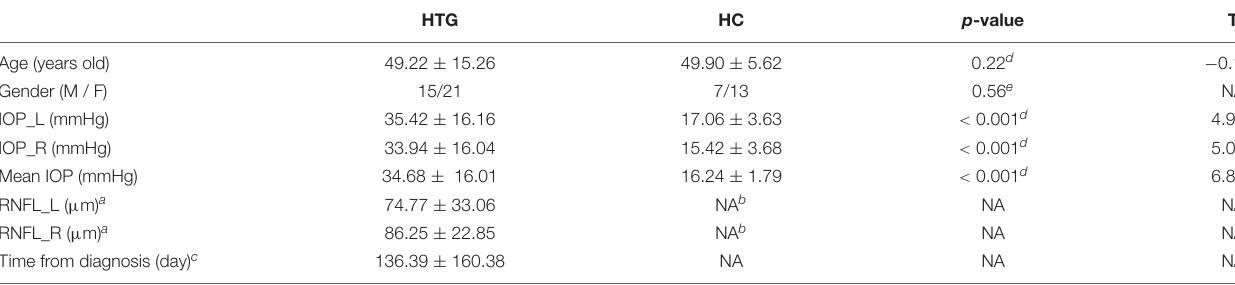
TABLE 1 | Demographic and clinical information of high-tension glaucoma patients and healthy